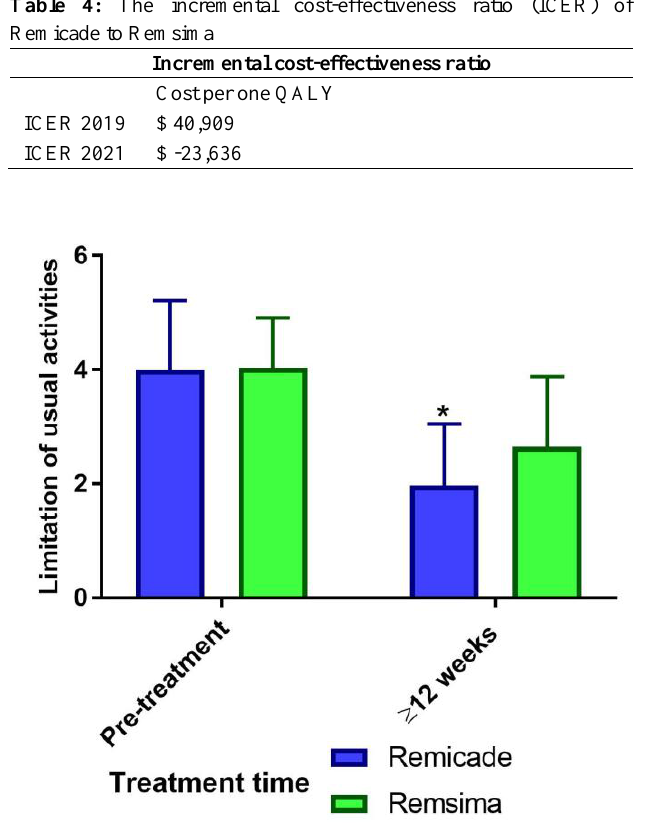
Table 4: The incremental cost-effectiveness ratio (ICER) of